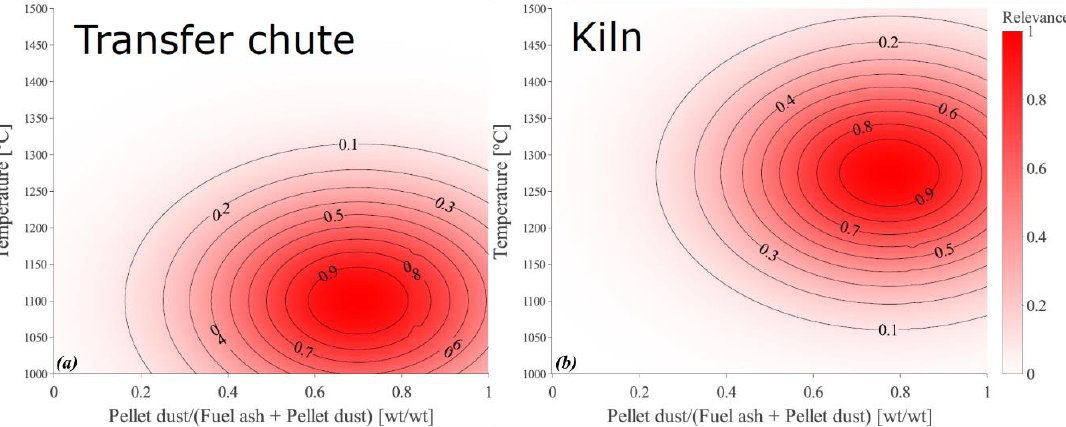
Figure 9. The relevance diagram assigning importance/relevance levels to different regions of the rotary kiln; ( a ) the highest relevance given to the transfer chute, average temperature = 1100 °C; ( b ) the highest relevance given to the kiln, average temperature = 1275 °C.